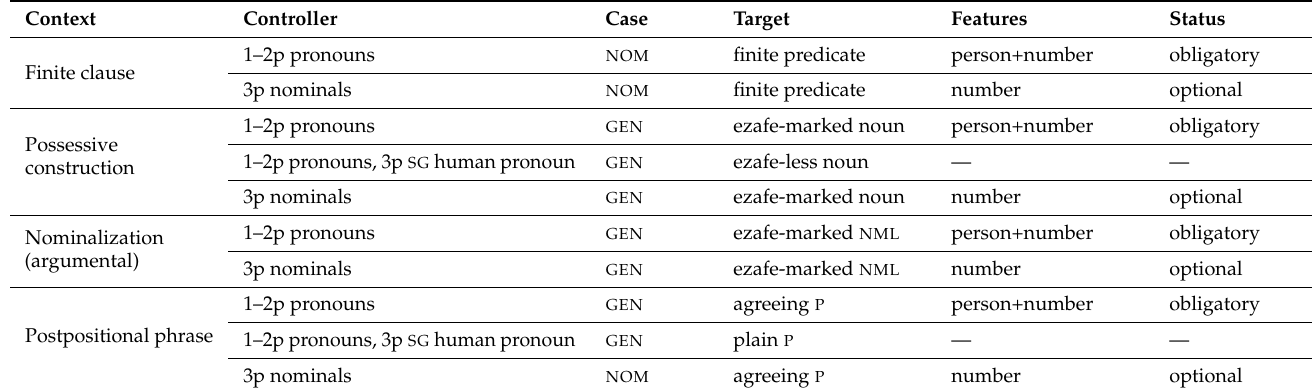
Table 3. Agreement configurations in